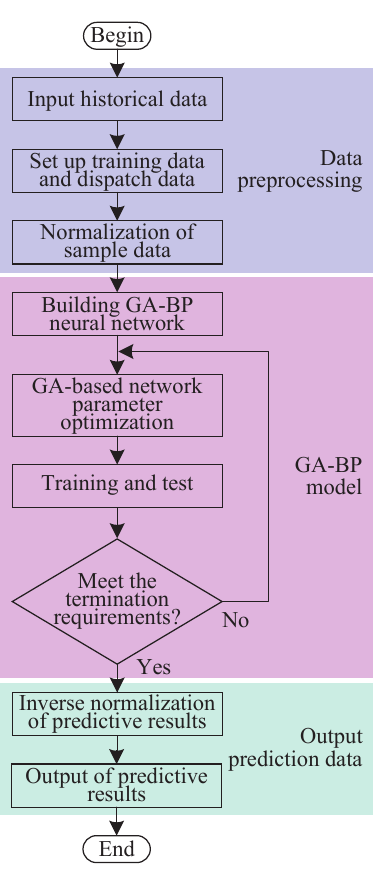
Figure 5. Flow chart of wind power